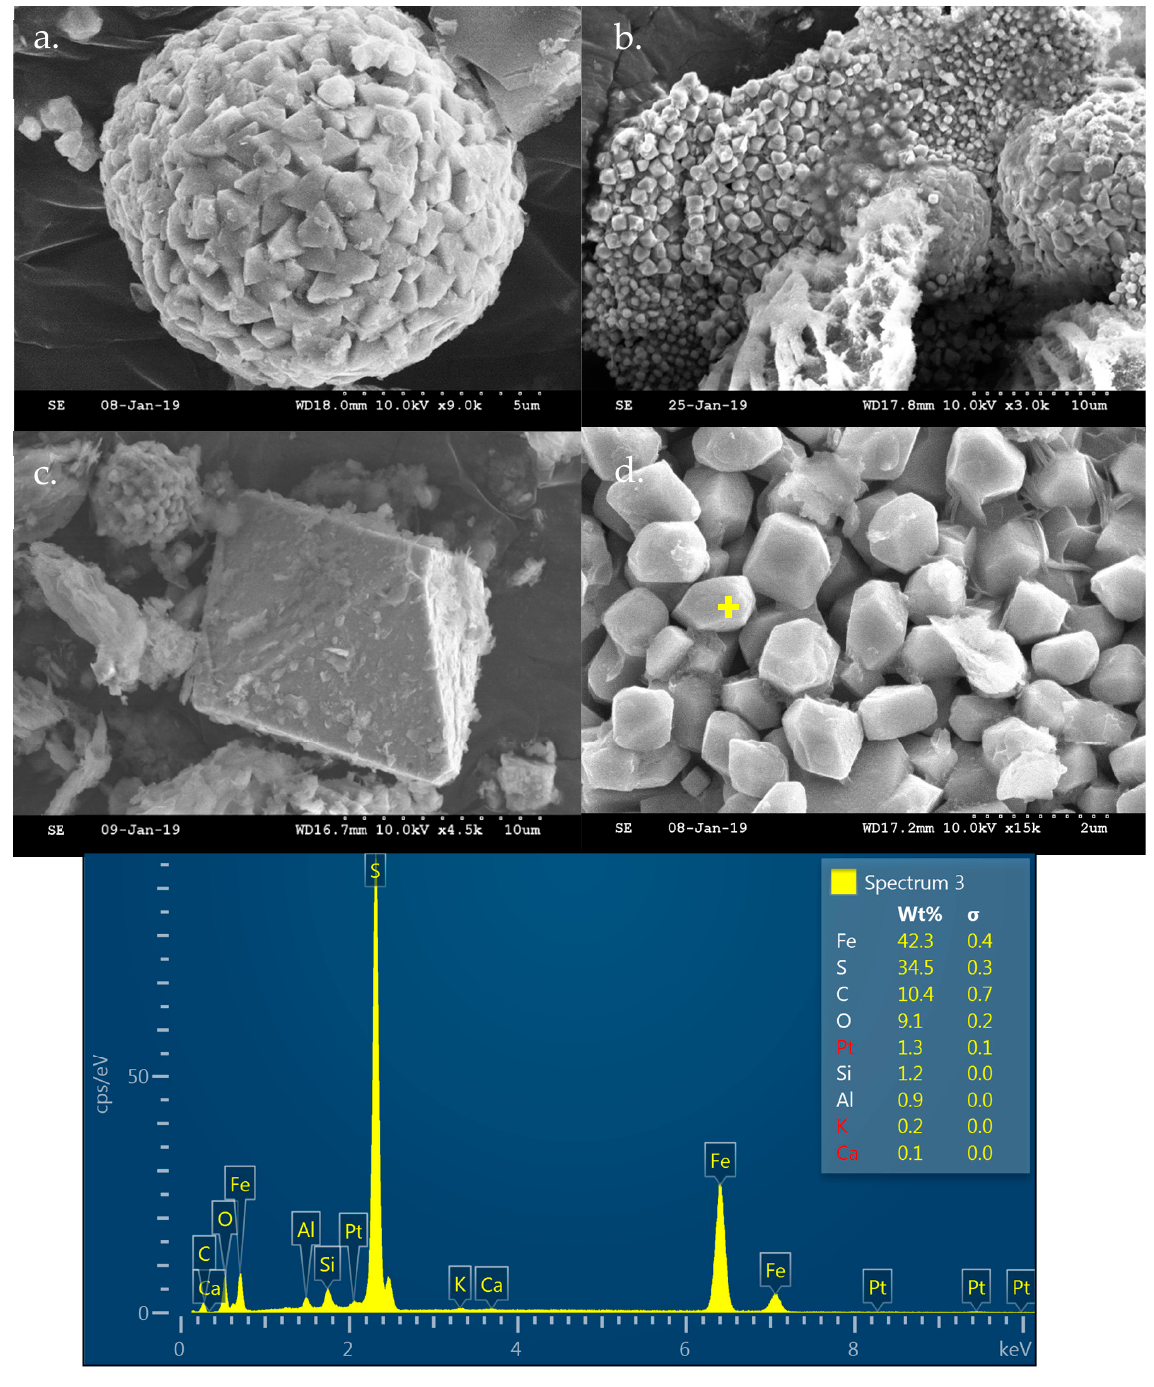
Figure 4. SEM images of various pyrite types found in the 2.20 SG sink fraction of the Baker seam coal course refuse material and EDX analysis showing the overall composition of these particles: ( a ) regular spherical shaped clusters, ( b ) composite mineral agglomerates, ( c ) large hexagonal crystals, and ( d ) small grain crystal